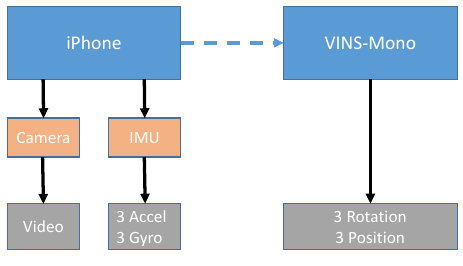
Figure 13. VIO data collection and